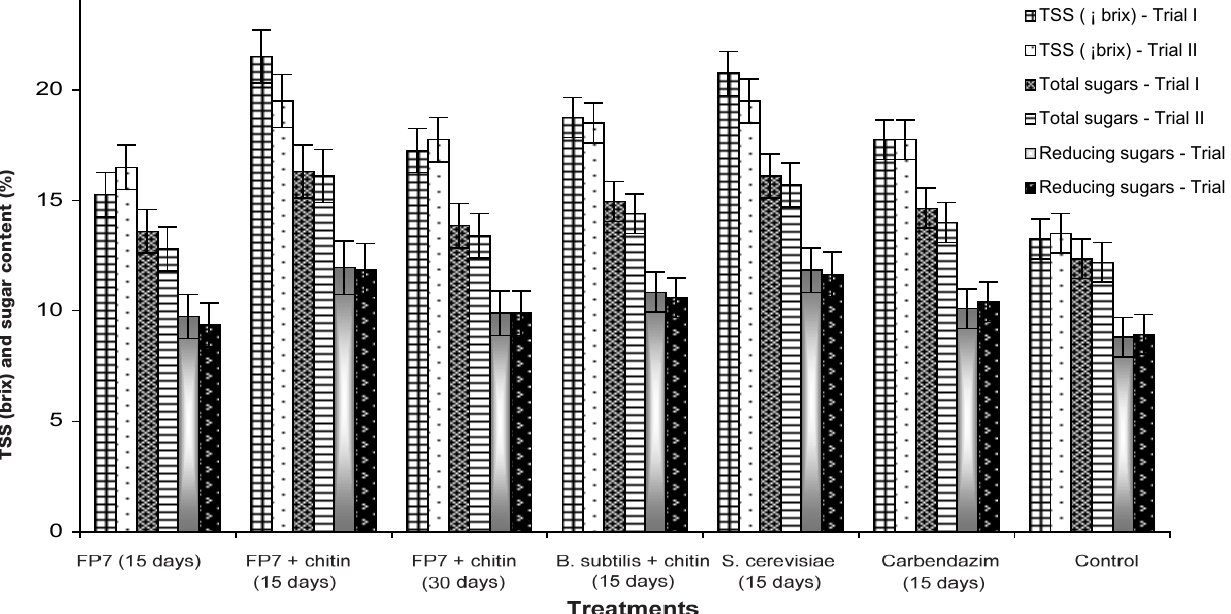
Fig. 8. Effect of pre-harvest application of biocontrol formulations on total soluble solids (TSS), total sugars and reducing sugars content in mango